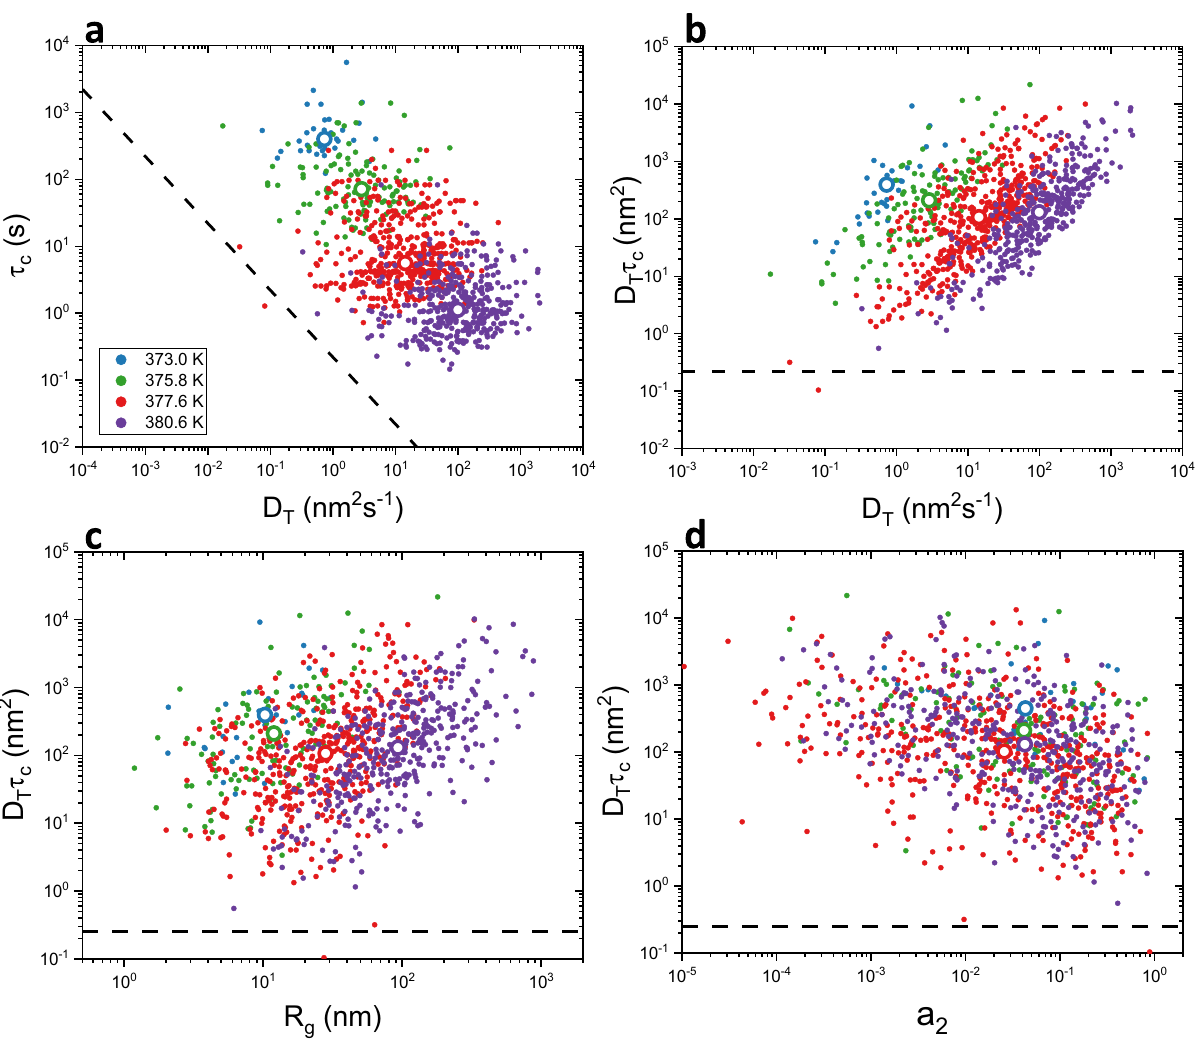
Fig. 2 Scatter plots of rotational and translational data obtained from single molecule trajectories. Each point represents a single molecule. Large open points show median single molecule values. Black dashed lines in all panels represent D T τ c = 0.25nm 2 , the expected value in the absence of DSE breakdown. a Rotational correlation time ( τ c ) vs. translational diffusion coef fi cient ( D T ). b Value of D T τ c vs. D T . Strong correlation between degree of breakdown as captured by deviation of the value of D T τ c from that expected (black dashed line) and D T suggests breakdown is primarily driven by translation. c Radius of gyration ( R g ) vs. the value of D T τ c shows molecules that explore larger areas tend to exhibit higher degree of breakdown. d Asymmetry coef fi cient ( a 2 ) vs. the value of D T τ c, with a 2 = 1 indicating an isotropic trajectory and smaller values indicating increasingly directional trajectories. Molecules with anisotropic trajectories tend to exhibit more breakdown. In all panels, color coding for temperature is as shown in the legend of ( a